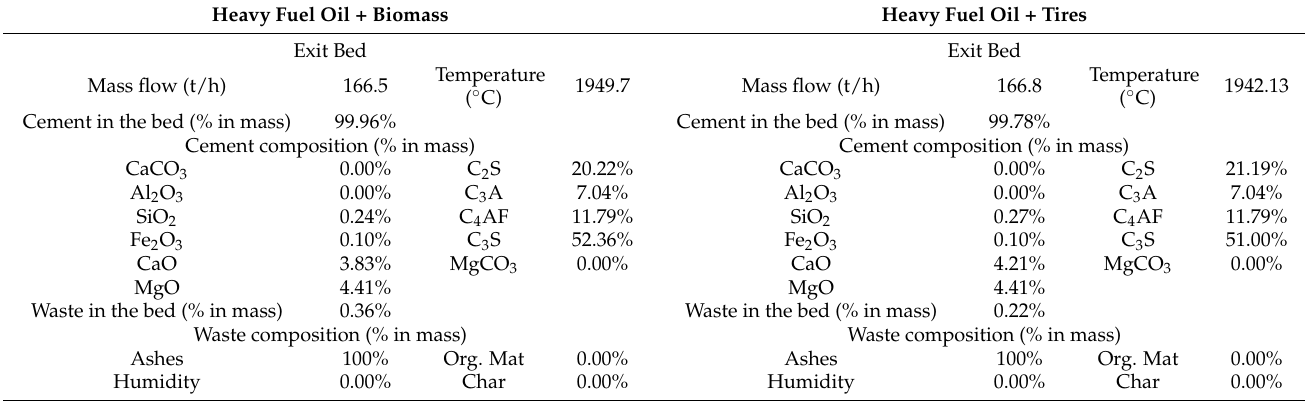
Figure 3. Comparison of gas velocity profiles obtained with two alternative fuels (above: biomass; below: tires). Table 9. Characteristics of cements obtained with two alternative